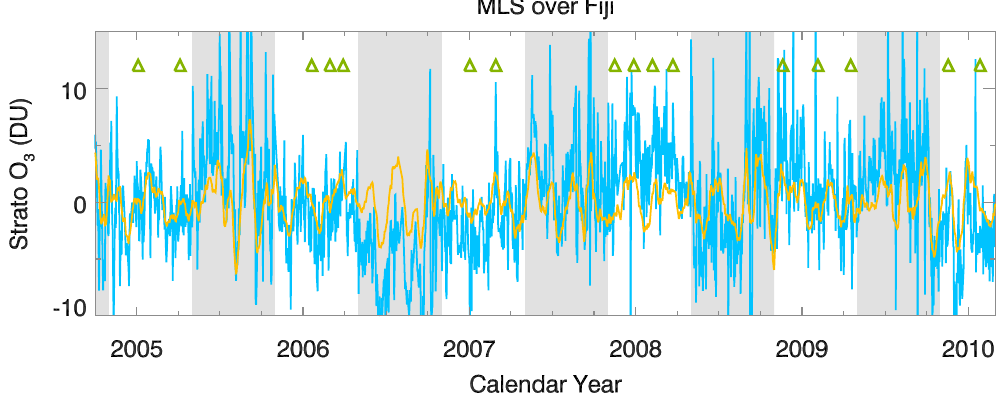
Fig. 3. The deseasonalized (cyan) and the bandpassed (orange) time series over Fiji observed by MLS. The grey shades are the boreal summer seasons (May–August), when data have been ignored in the MJO-phase averages. The strong MJO events during the observational periods are denoted by the triangles for MLS as in Fig. 1 (b) .